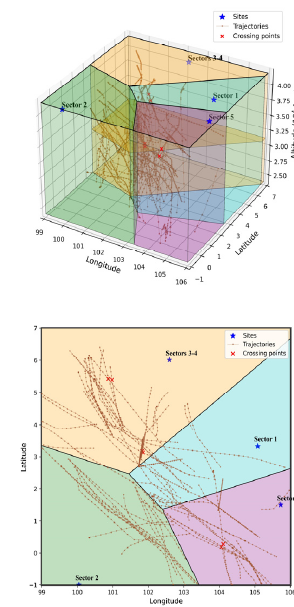
Figure 8. Airspace sectorization results for area one (i.e., solutions of [0.128, 44], [0.082, 45], and [0.064, 46] in Run 1). ( a ) Results in 3D view; ( b ) results in 2D view; ( c ) intra-sector and inter-sector workloads for each solution.